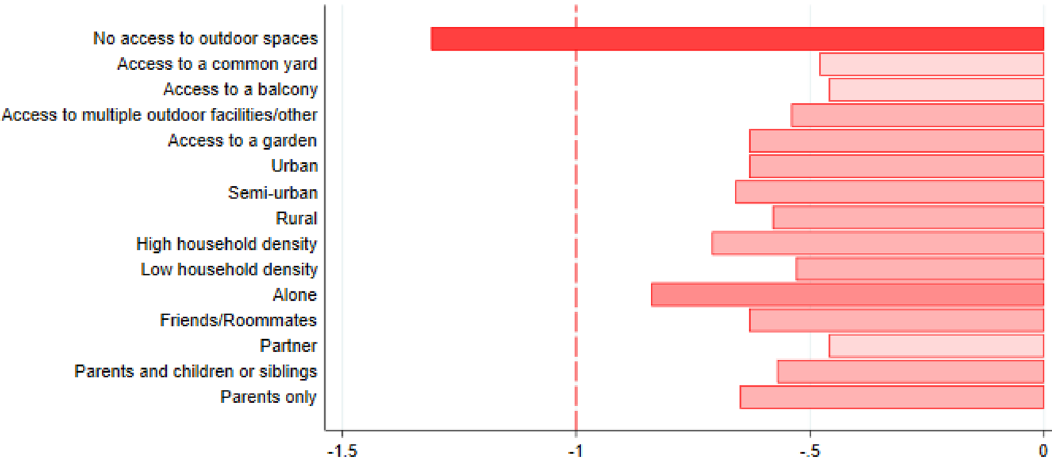
Figure 3. Changes in mental well-being (SWEMWBS) scores indicative of meaningful changes, according to housing conditions (No. = 7445). SWEMWBS: Short Warwick-Edinburgh Mental Well-Being Scale. Unadjusted means for changes in mental well-being scores on the SWEMWBS, by housing conditions. Red dashed line indicates minimum change considered meaningful at the individual level on the SWEMWBS 16 and incrementally darker shades of red indicate incrementally larger decreases in SWEMWBS